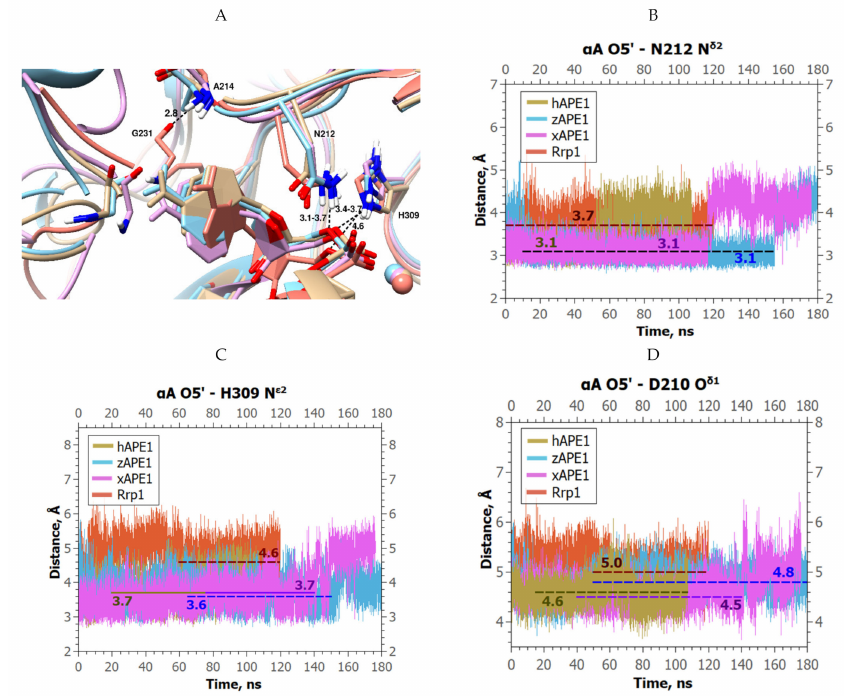
Figure 6. MD trajectories and structures of the complexes of APE1-like endonucleases with α A- containing DNA (hAPE1 is sand-colored, zAPE1 is cyan, xAPE1 is magenta, and Rrp1 is red): ( A ) Structural models of enzyme–substrate complexes and average lengths of H-bonds. The average lengths of H-bonds between His309 N ε 2 and α A O5 (cid:48) , between Asn212 N δ 2 and α A O5 (cid:48) , and between Gly231 O and Ala214 N are presented; alterations of ( B ) α A O5 (cid:48) –Asn212 N δ 2 , ( C ) α A O5 (cid:48) –His309 N ε 2 , and ( D ) α A O5 (cid:48) –Asp210 O δ 1 distances throughout the MD trajectories of the analyzed APE1-like enzymes in complex with α A-containing